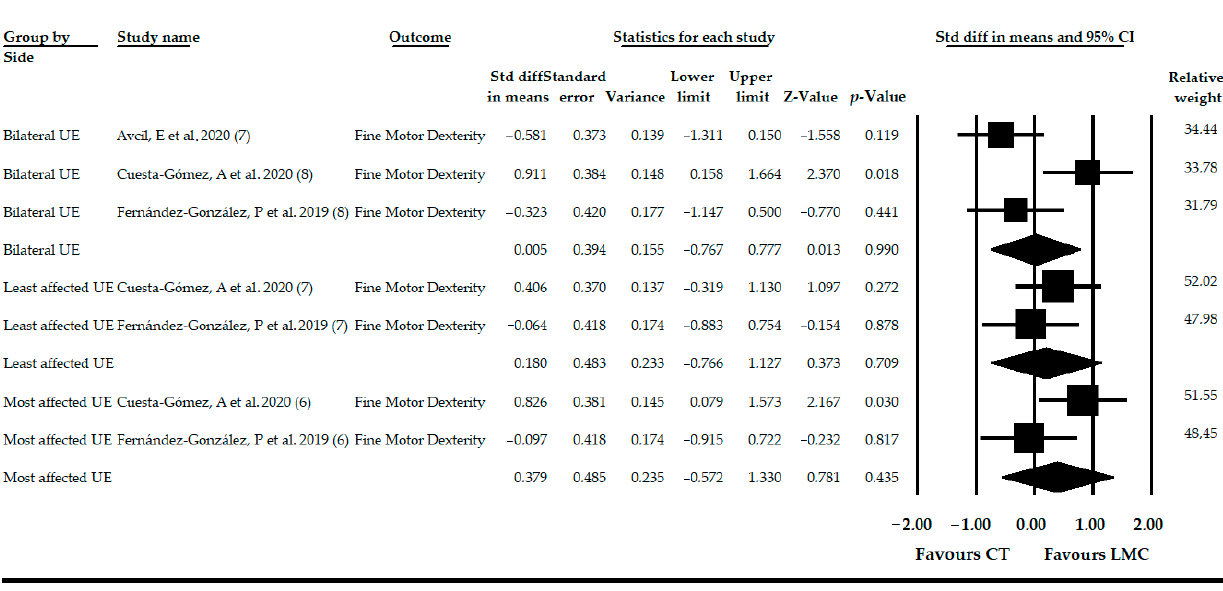
Figure 5. Forest Plot of the effect of LMC-based therapy on recovery of fine motor dexterity in patients with non-acute CNSD.